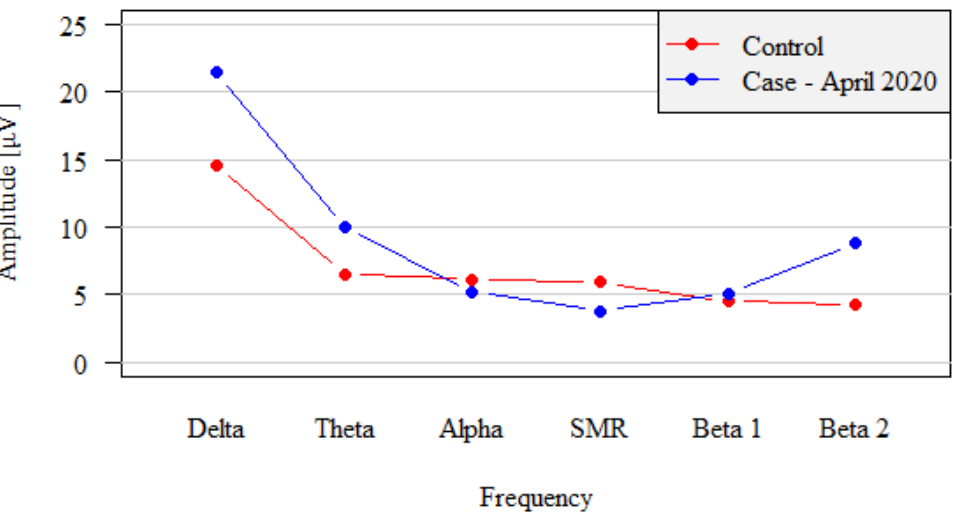
Figure 2. Comparison between right hemispheric (C4) QEEG recordings in test patient with panic attacks before the treatment (blue dots and lines) vs. non-affected subject (control, red dots and lines).